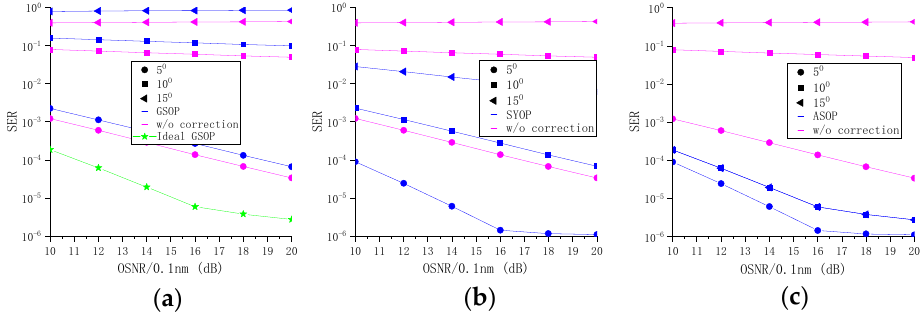
Figure 8. Symbol error rate (SER) versus the optical signal-to-noise ratio (OSNR) with different ϕ IQ of 5°, 10°, and 15° for the ( a ) GSOP, ( b ) the SYOP, ( c ) and the ASOP; W/O: without.